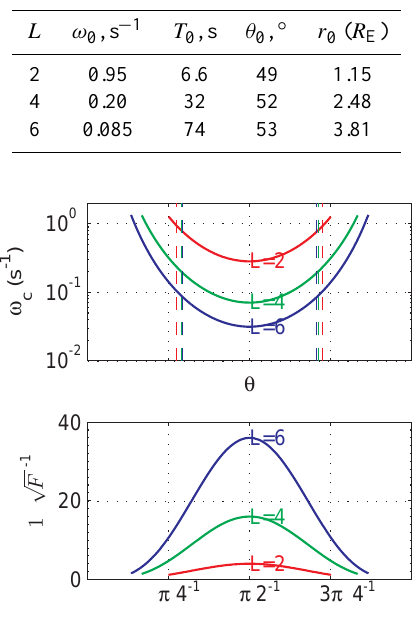
Figure 1. The parameter ω c (with B 0 = 0 . 31 Gauss, a = 6 . 4 × 10 8 cm and ρ e = 7 amucm − 3 ) and the amplitude factor as a func- tion of θ for various L values of a dipole field. The vertical lines mark the location (colatitude) where ω c = ω 0 , the eigenfrequency of the corresponding fundamental